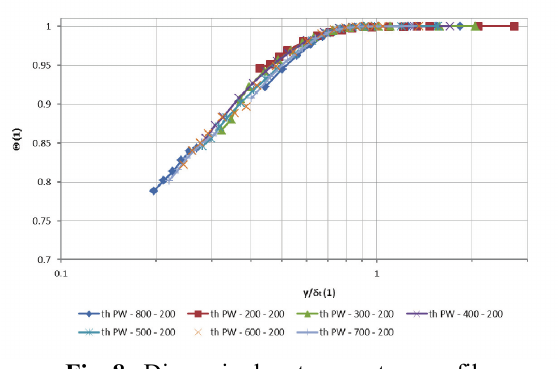
Fig. 6 Turbulence profiles Tu =f( y / δ ), x =(300 − 950) mm. Unheated